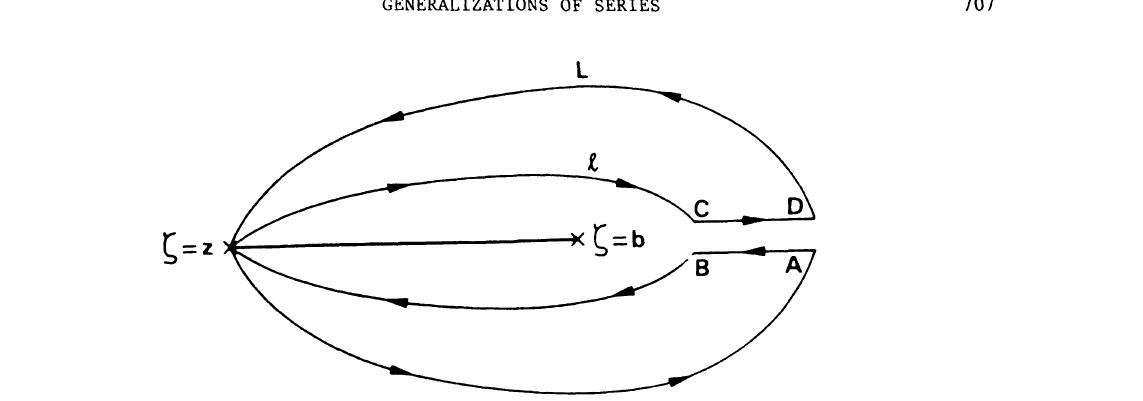
Figure 6-One of the elements of Figure 4, is the pair of inner L (outer L) teardrop loops, going clock- (counterclock-) wise around the same finite =z branch-cut joining to =b, which is surrounded by a composite loop, also including the segments AB and CD. which cancel in the integration of an univalent function.